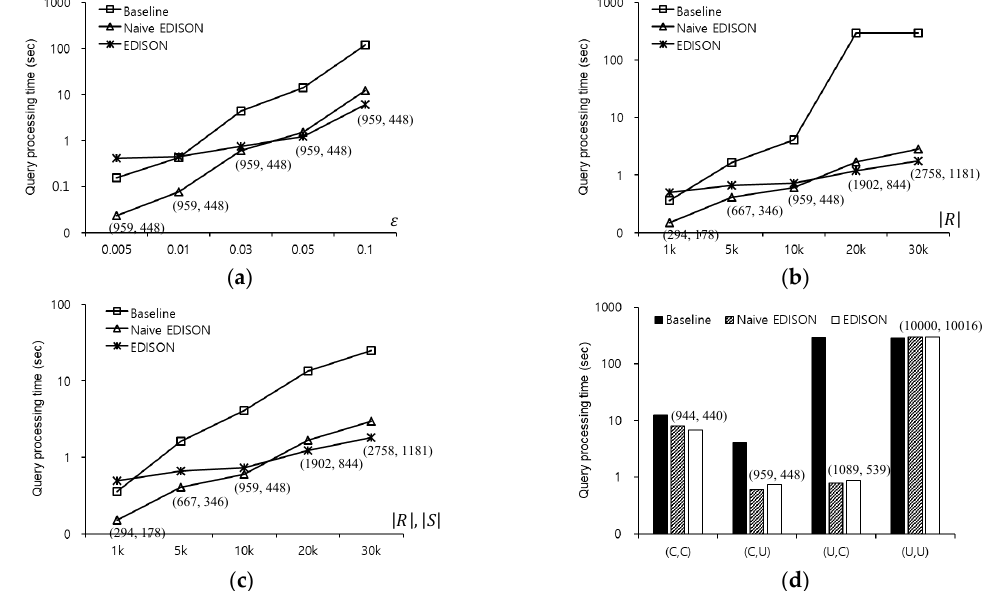
Figure 15. Comparison of the baseline, naive EDISON, and EDISON methods for CAL ( a ) varying ε ; ( b ) varying | R | ; ( c ) varying | R | and | S | ; ( d ) varying the distributions of objects.